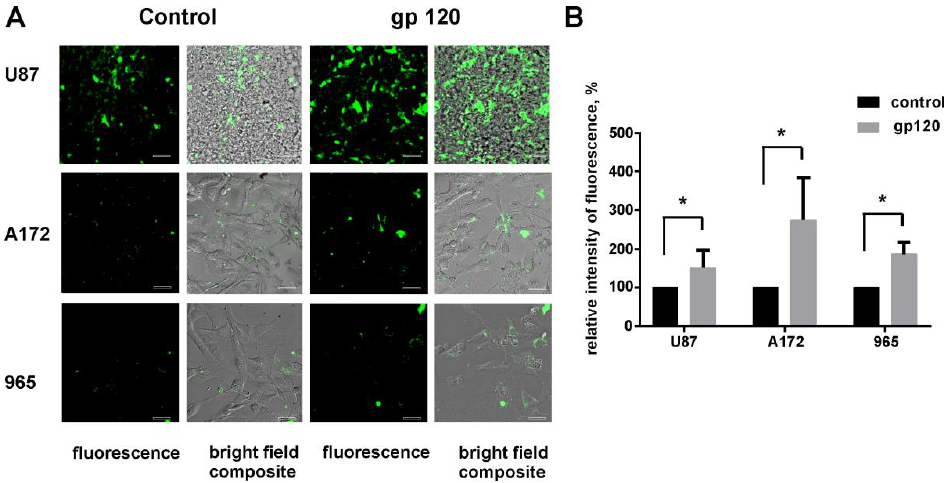
Figure 6. Gp120 increases glucose uptake in glioma cells. Glucose uptake assays were performed for untreated and gp120 treated for 7–10 days U87, A172 and 965 glioma cells. Confocal images showing the uptake of GluTracker reagent in the cytoplasm ( A ) and quantification of relative fluorescence intensity ( B ) are presented. Mean ± S.E. and significant differences between control and gp120 treatment (*) are shown ( p < 0.05). Unpaired t -tests were used to determine the significance between groups. Five independent experiments ( n = 5) were used for statistical analysis. Scale bar: 20 µ